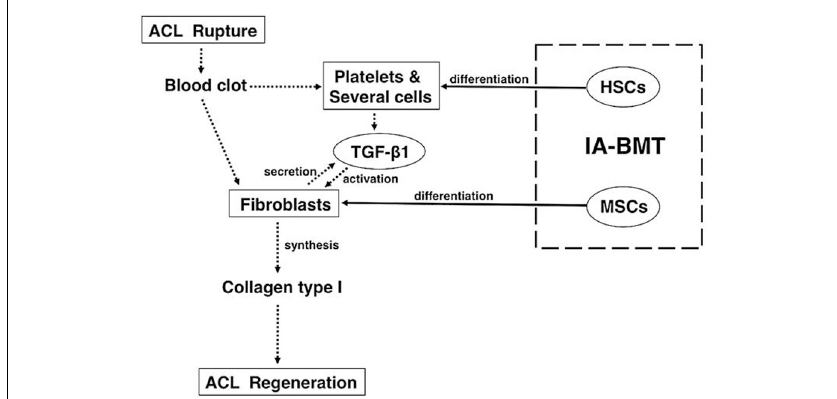
FIGURE 1 | Mechanisms underlying the treatment of anterior cruciate ligament healing by intra-articular bone marrow transplantation with fresh whole bone marrow cells. For anterior cruciate ligament (ACL) healing, fresh whole bone marrow cells (BMCs) that are primarily comprised of mesenchymal stem cells (MSCs) and hematopoietic stem cells should be preferably used because the combination has significant advantages over MSCs only. The dotted arrows show the cascade of events that lead to ACL healing in general. The solid arrows show the effects of intra-articular bone marrow transplant with fresh whole BMCs. (This figure was taken from Oe et al.,